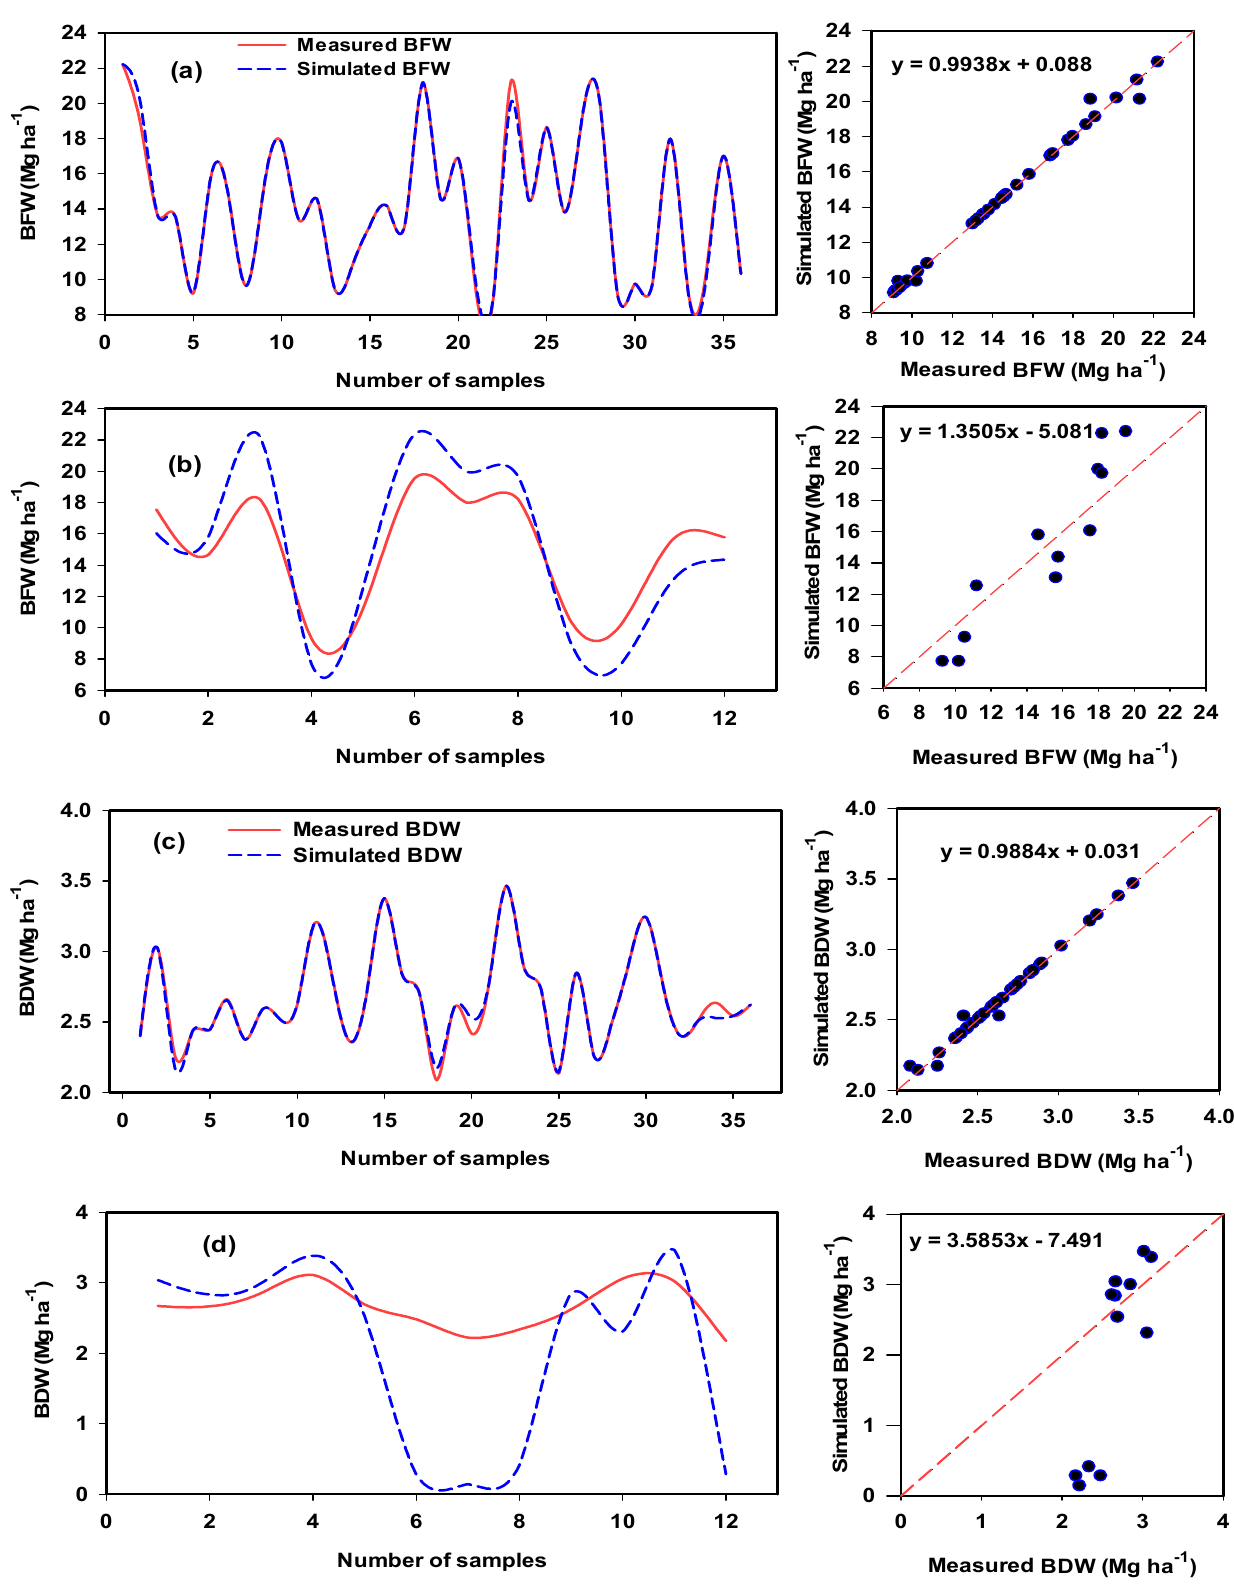
Figure 11. Comparison between training series ( a , c ) and testing series ( b , d ) for biomass fresh weight (BFW) and biomass dry weight (BDW) of potato varieties using the developed ANFIS model.